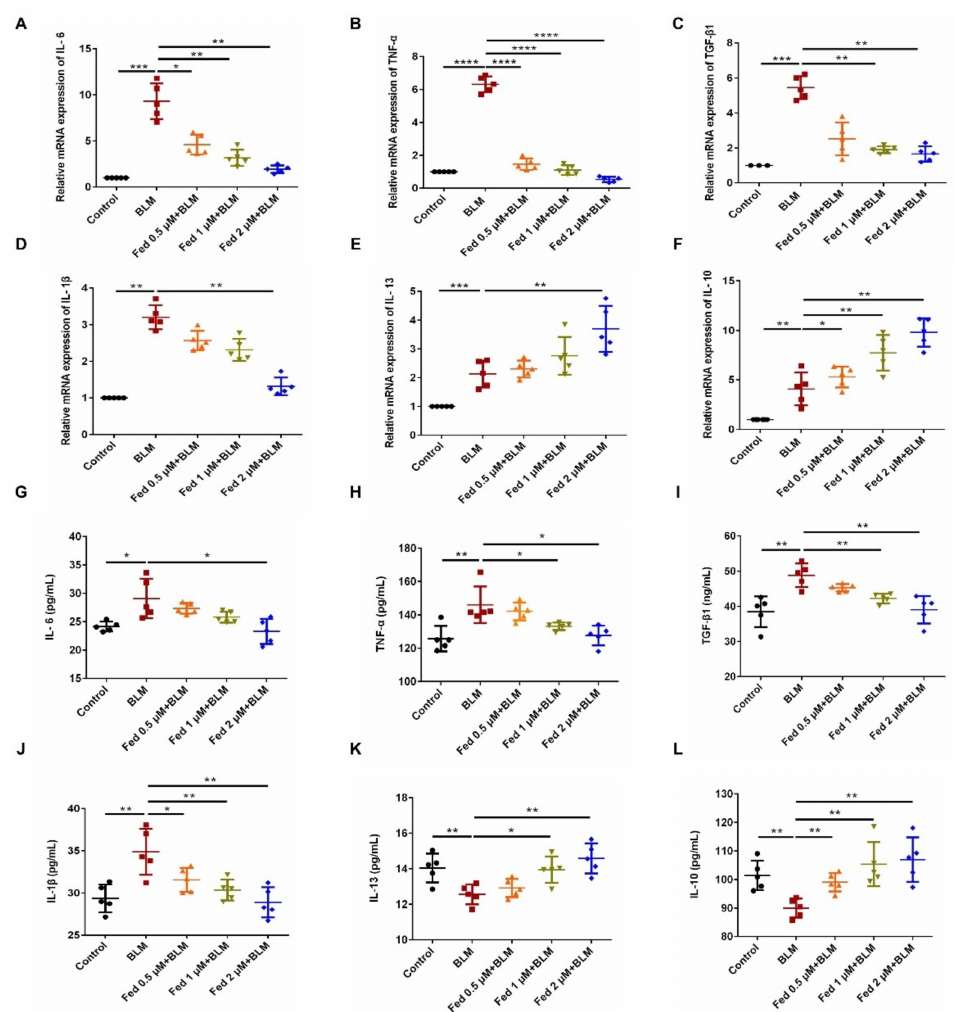
Figure 3. Fedratinib regulated the production of inflammatory cytokines in lung epithelial cells. ( A – F ) MLE12 cells were treated with BLM (5 U) and Fed (0.5, 1 and 2 µ M) for 24 h. TGF- β 1, TNF- α , IL-1 β , IL-6, IL-13 and IL-10 were analyzed by real-time PCR in MLE12 cells. ( G – L ) MLE12 cells were treated with BLM (5 U) and Fed (0.5, 1 and 2 µ M) for 24 h. The expression of inflammatory factors including TGF- β 1, TNF- α , IL-1 β , IL-6, IL-13 and IL-10 in cell supernatant was detected using an ELISA kit. Data are presented as the means ± SD ( n = 5). Comparisons between groups were achieved using one-way analysis of variance (ANOVA). * p < 0.05, ** p < 0.01, *** p < 0.001, **** p <